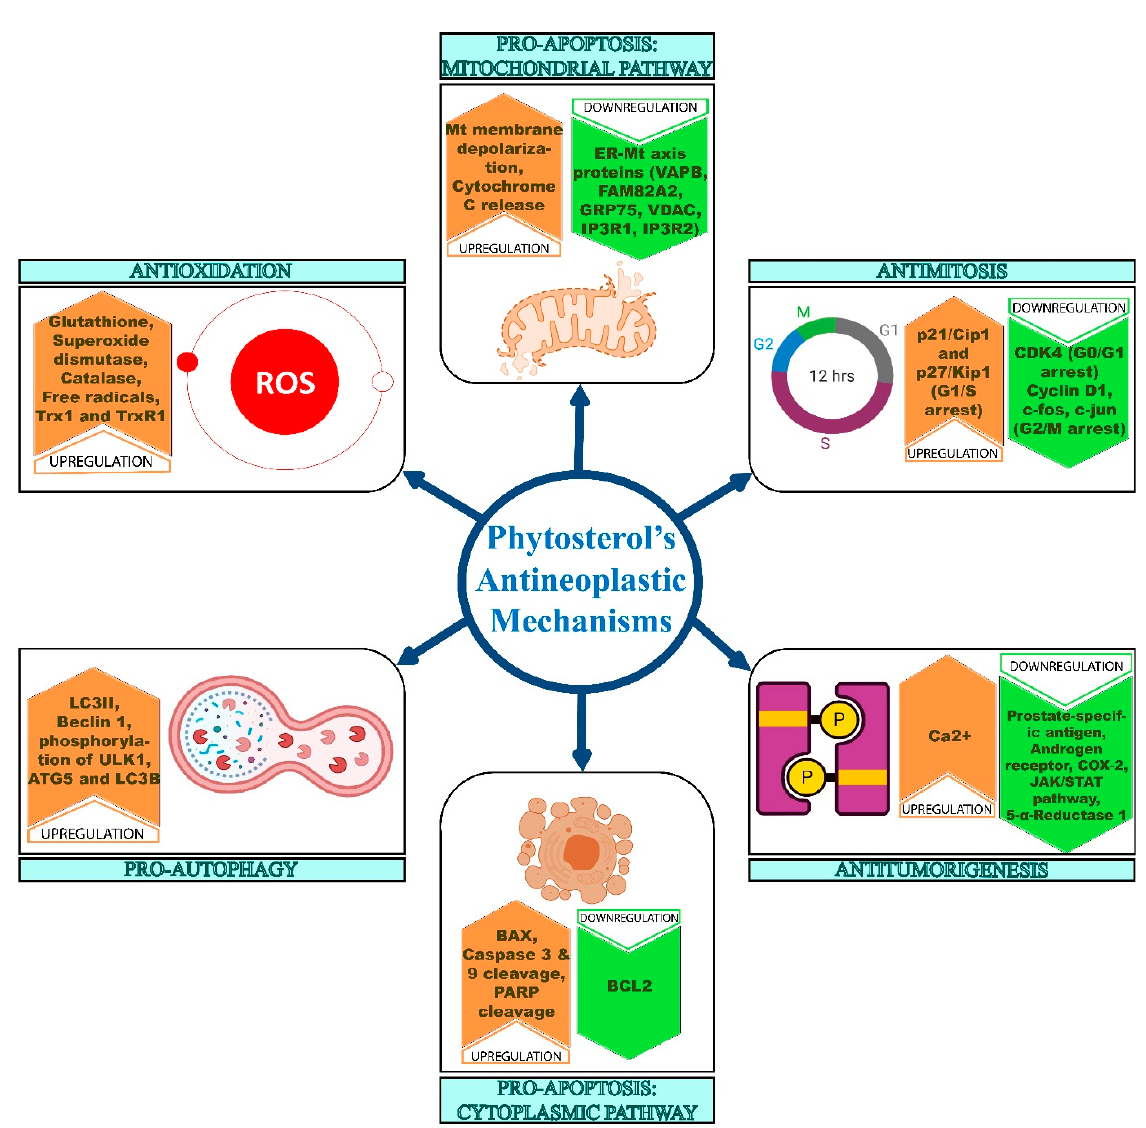
Figure 5. Anticancer mechanisms of phytosterols. The different modes of action giving rise to the anticancer properties of phytosterols act in different gene pathway. Controlled regulation of genes involved in antioxidation, apoptosis and antimitosis restricts the growth of the cancer cells.